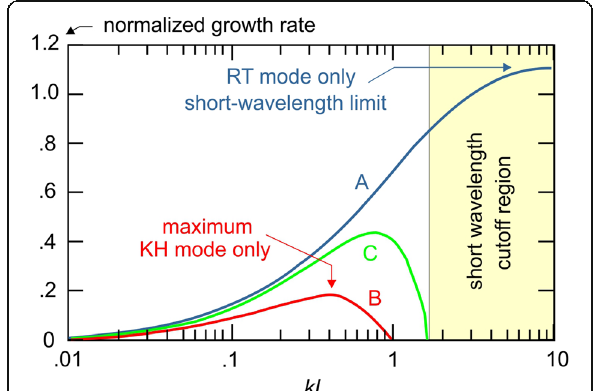
Fig. 17 Plot of the linear growth rate for the interchange instability in the presence of a velocity shear. Curve A (blue) represents the growth rate for the interchange instability. Curve B (red) represents the collisionless KH instability only. Curve C (green) represents the interchange instability modified by presence of velocity